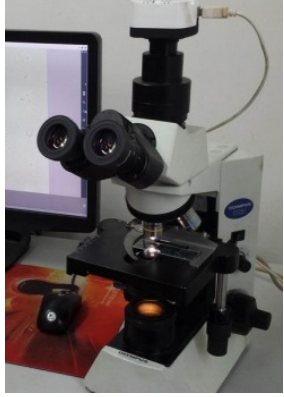
Figure 4. The electronic microscope.